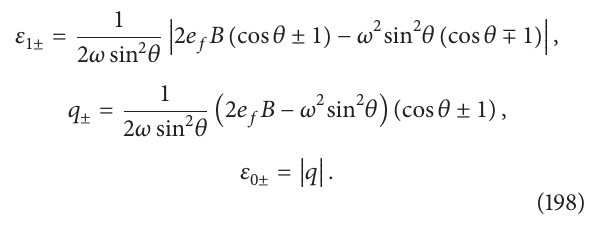
= 3 MeV, 𝑚 = 5 MeV, and 𝑚 = 92 MeV. Adopted 𝑢 𝑑 𝑠